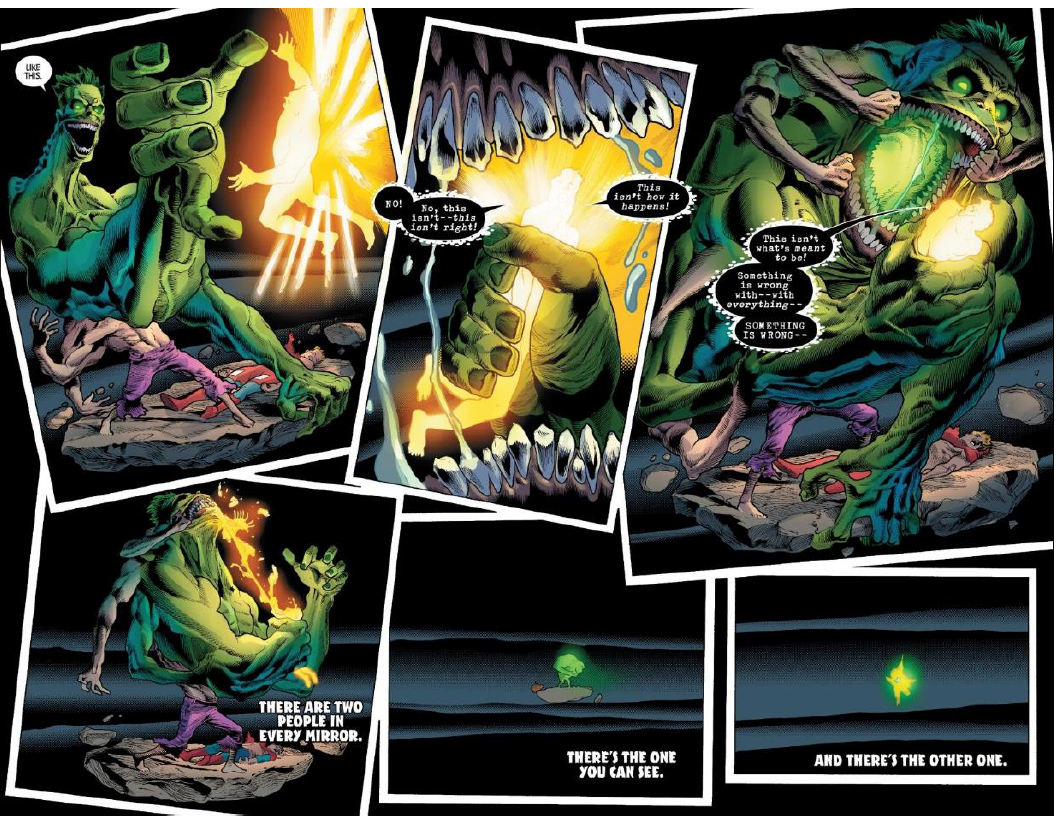
Figure 3. The Hulk consuming Galactus in Immortal Hulk